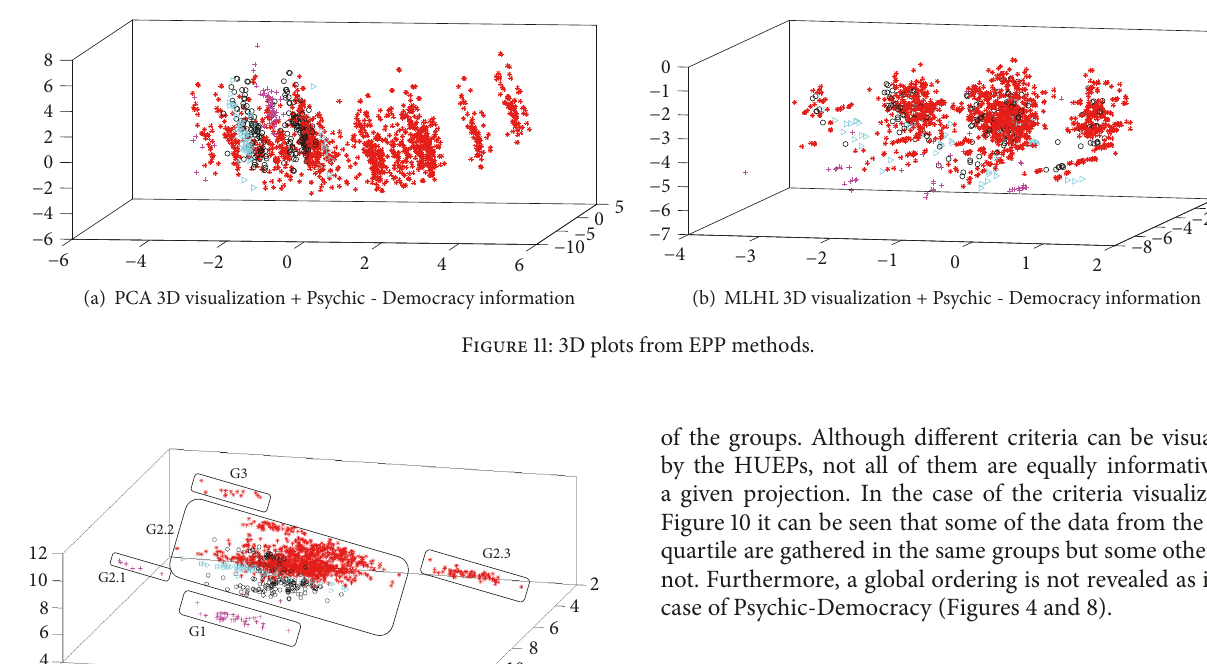
Figure 10: Comparison of HUEPs when visualizing different distance criteria through the glyph metaphor.